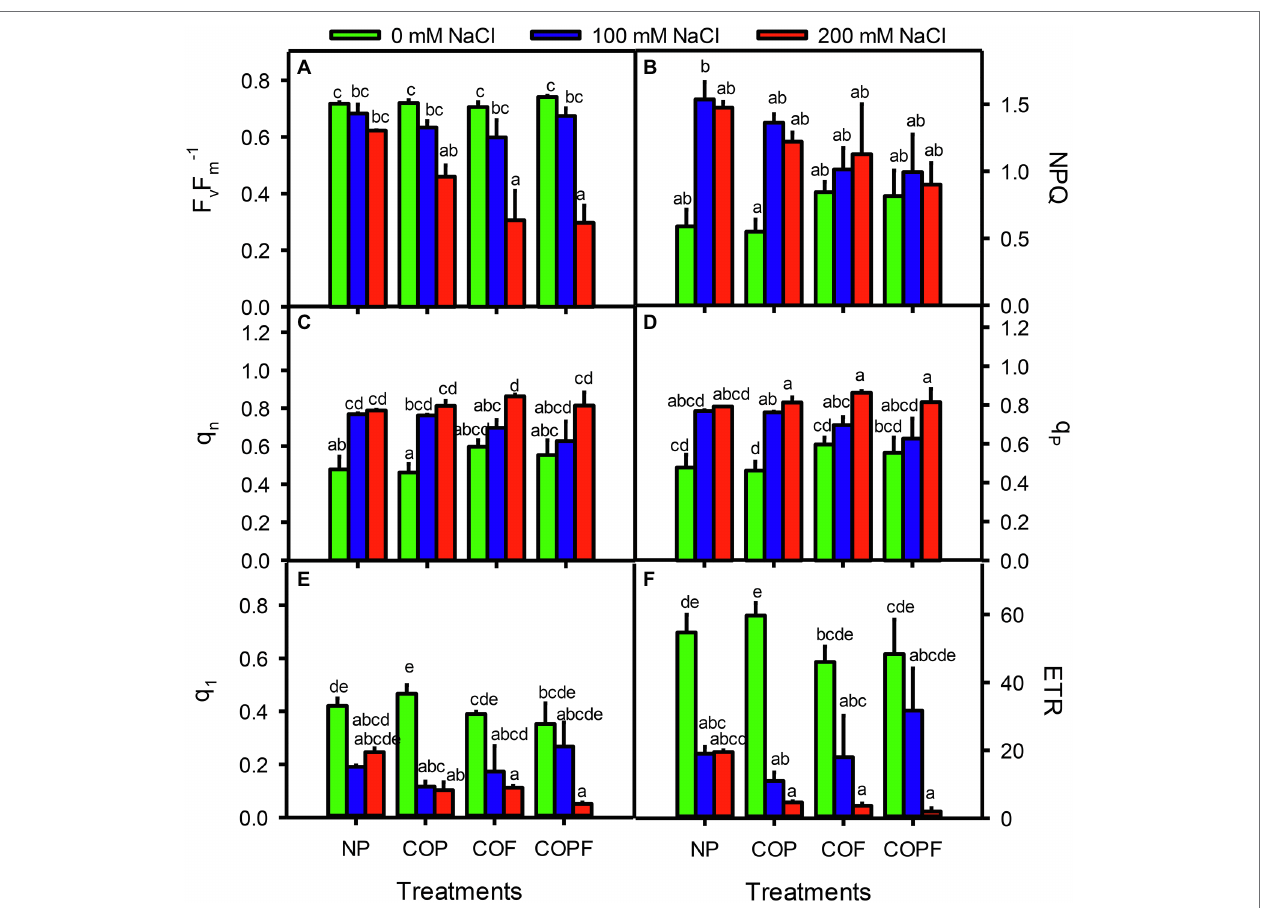
FIGURE 3 | Effect of salinity and coumarin applications on Chlorophyll Fluorescence in Sorghum bicolor plants. F v /F m (A) , NPQ (B) , q n (C) , q p (D) , q l (E) , ETR (F) . Plants were treated with 0 mg L − 1 coumarin (NP), 100 mg L − 1 coumarin as seed priming (COP), 100 mg L − 1 coumarin as foliar application (COF) and combined treatment (COPF), under 0, 100 and 200 mM NaCl. Values are represented as means ±SE (n = 3). Different letters represent significant differences ( p < 0.05) by Tukey’s HSD test.